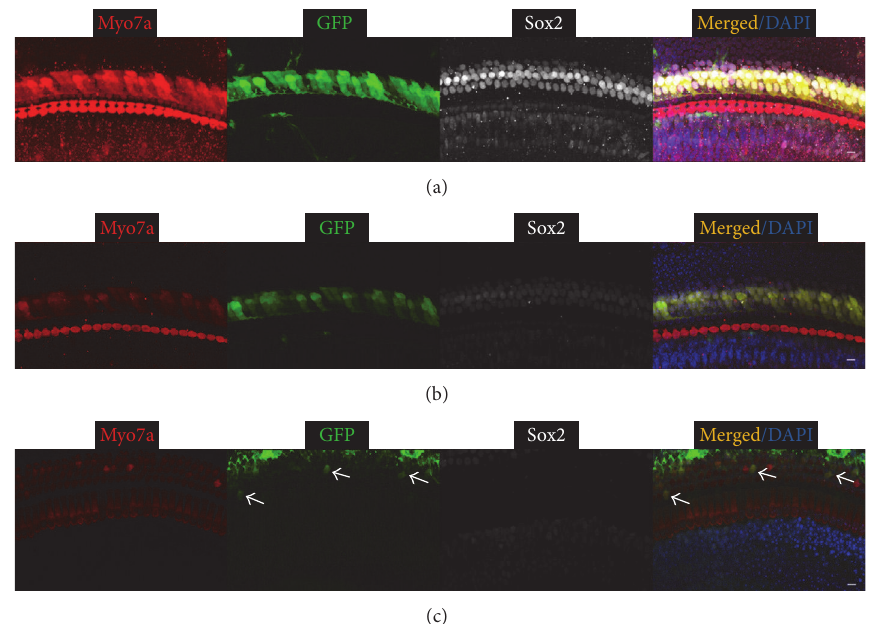
Figure 6: Ad-GFP-VB transduces supporting cells and OHCs in the mouse cochlear when injected at P4. Representative confocal images of whole-mount fluorescent immunolabeling of the cochlea to illustrate the basal (a), middle (b), and apical turns (c). Ad-GFP-VB transduces SCs at basal (a) and middle (b) and occasional OHCs at apical turns (arrows in (c)). Scale bars: 10 𝜇 m.